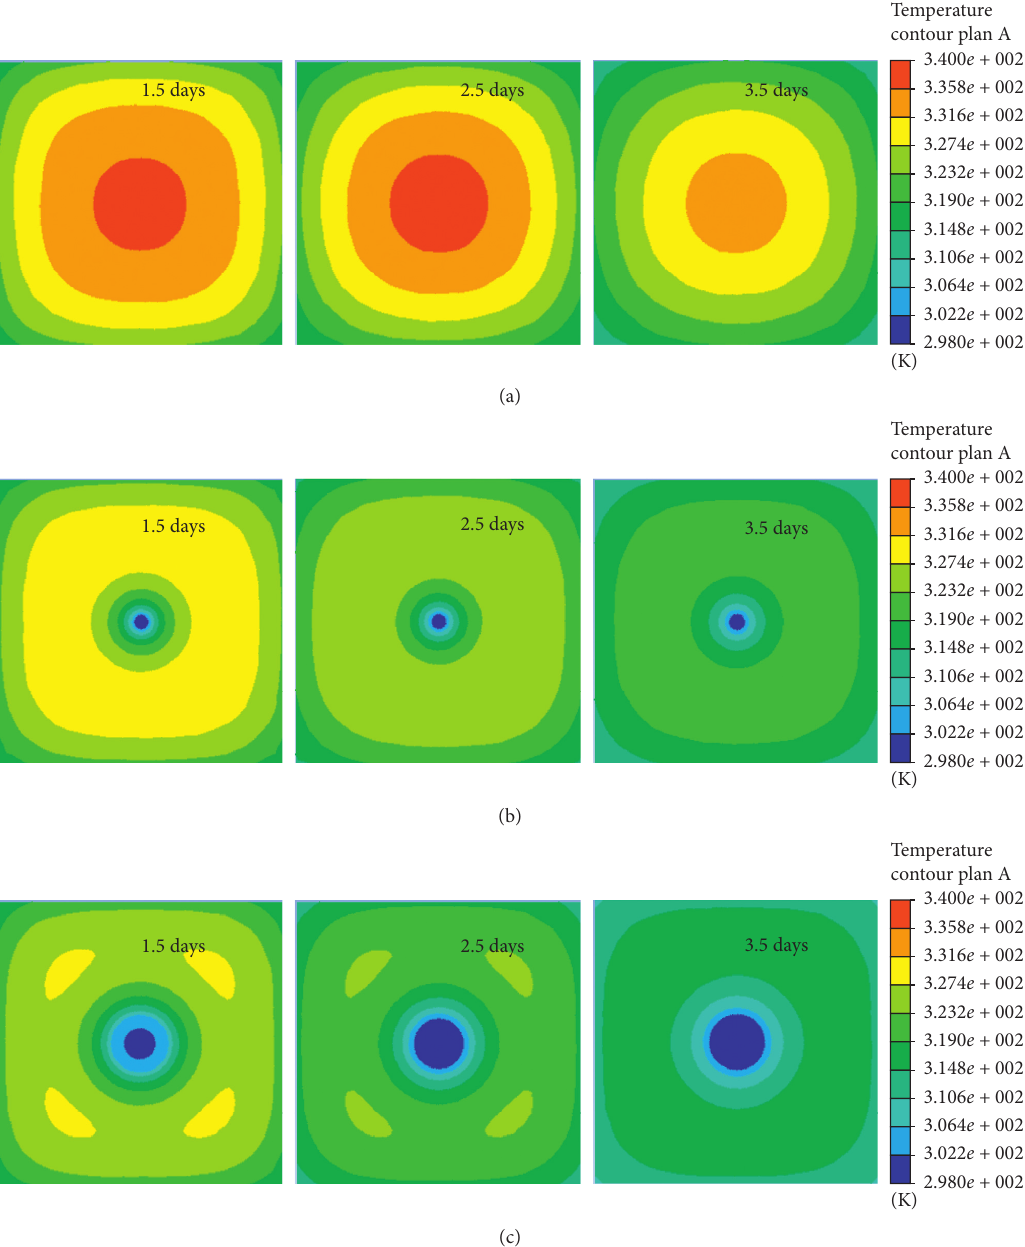
Figure 8: Temperature distributions of plane A1: (a) concrete without CP; (b) concrete with CP; (c) concrete with AFCP.